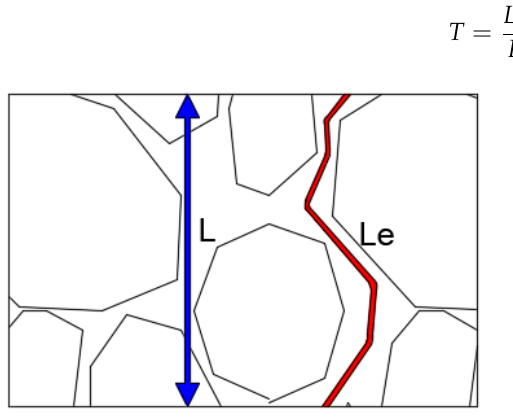
Figure 2. Schematic of a curvature.